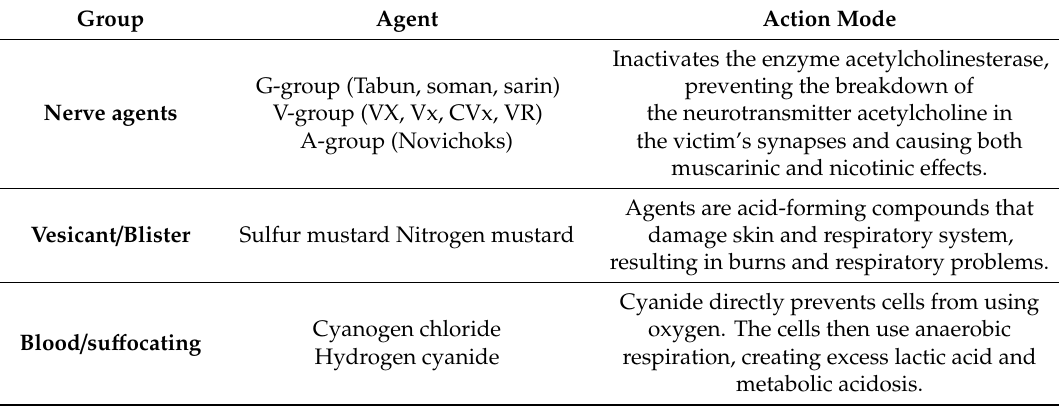
Table 2. Main chemical threat agents. Republished with permission from [87]; permission conveyed through Copyright Clearance Center,